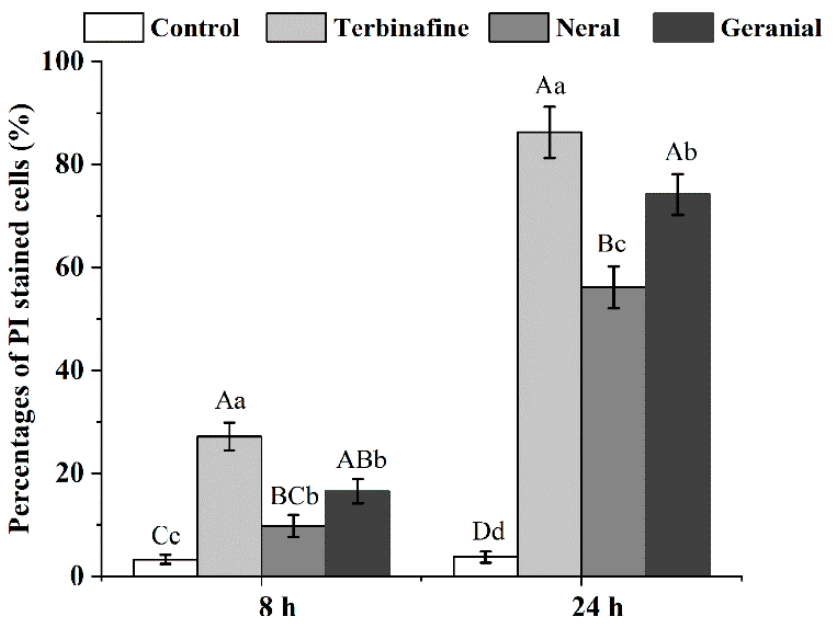
Figure 5. Percentages of PI-stained Trichophyton rubrum conidia in different treatment groups at 8 h and 24 h post-treat- ment. At specific time intervals, columns with lowercase or uppercase letters indicate significant or highly significant differences ( p < 0.05 or p <